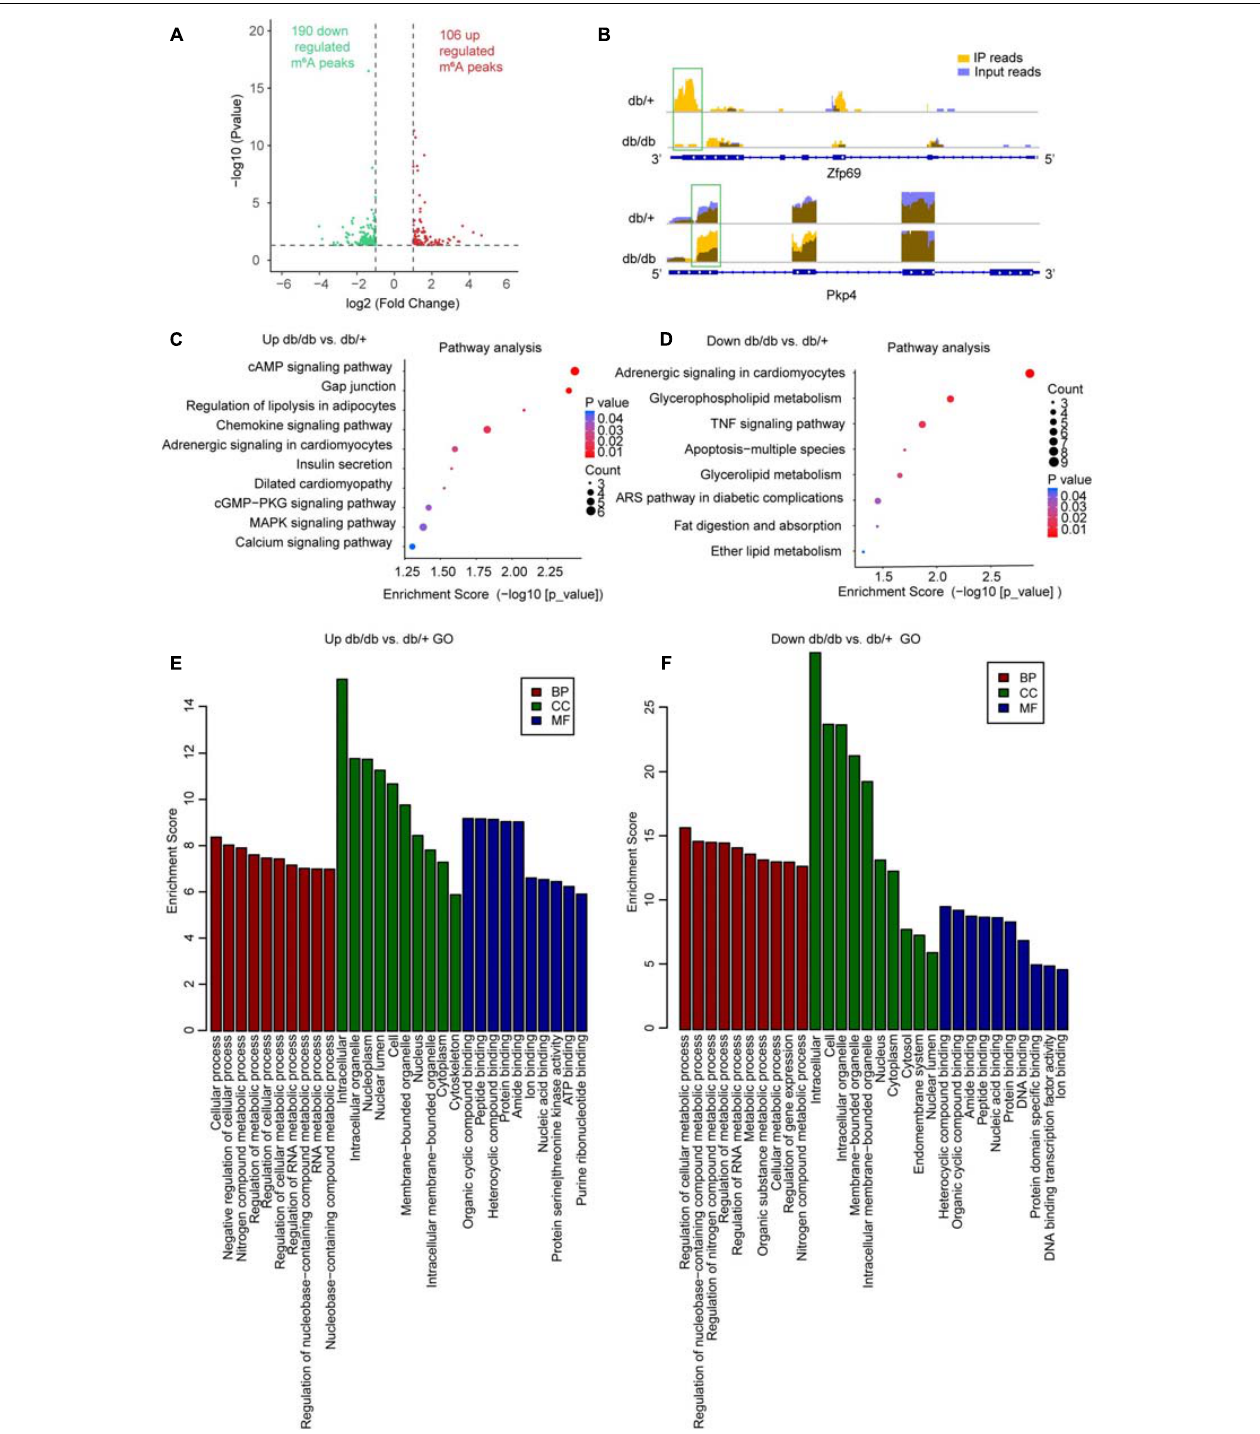
FIGURE 3 | Global m 6 A modification changes in DCM hearts compared with control heart tissue. (A) Identification of 106 hyper-methylated and 190 hypo-methylated m 6 A peaks that were significantly increased or decreased (fold-change > 2, P < 0.05) in abundance, respectively, in the DCM compared with NC samples. (B) m 6 A abundance in Zfp69 and Pkp4 mRNA transcripts in the NC and DCM samples, as detected by m 6 A-seq; m 6 A peaks in green rectangles showed significantly increased or decreased abundance (fold-change > 2, P < 0.05) in the DCM compared with NC samples. (C–F) Gene ontology enrichment and pathway analyses of differentially altered m 6 A mRNA in DCM compared with NC groups; top 10 significantly enriched pathways for upregulated (C) and downregulated (D) genes; major gene ontology terms significantly enriched for up-methylated (E) and down-methylated (F) genes. ARS pathway involved in diabetic complications: AGE-RAGE